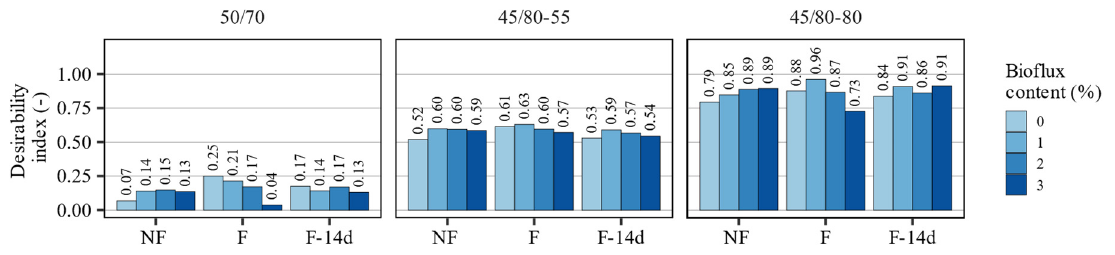
Figure 11. The desirability indices calculated using the multivariate optimization methodology.